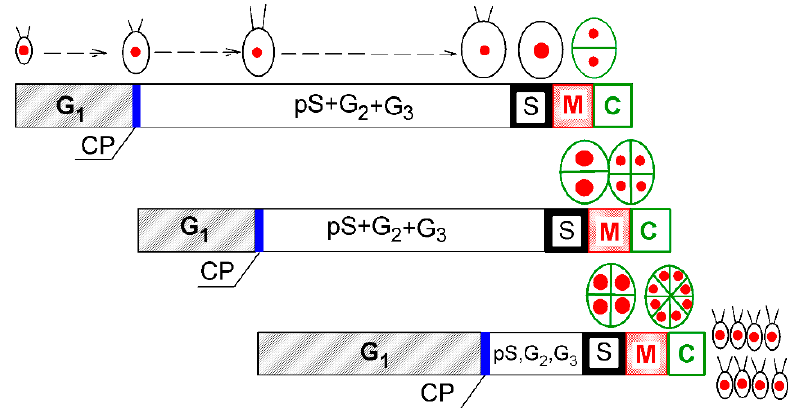
Figure 1. Schematic diagram of growth and the cell cycle in a single cell of Chlamydomonas reinhardtii . The schematic pictures reflect increasing cell size. The red full circles inside the cells illustrate the size and number of nuclei. Larger red circles indicate a doubling of DNA. Green ellipsoids and lines represent protoplast division. Diagram shows a model of cell cycle progression in C. reinhardtii dividing by multiple fission into 8 daughter cells. Three bars indicate three overlapping growth and reproductive sequences terminated by division into 2, 4, and 8 daughter cells, respectively. Precommitment period (G1): the period until threshold critical cell size for commitment to divide (CP) is reached and CP is